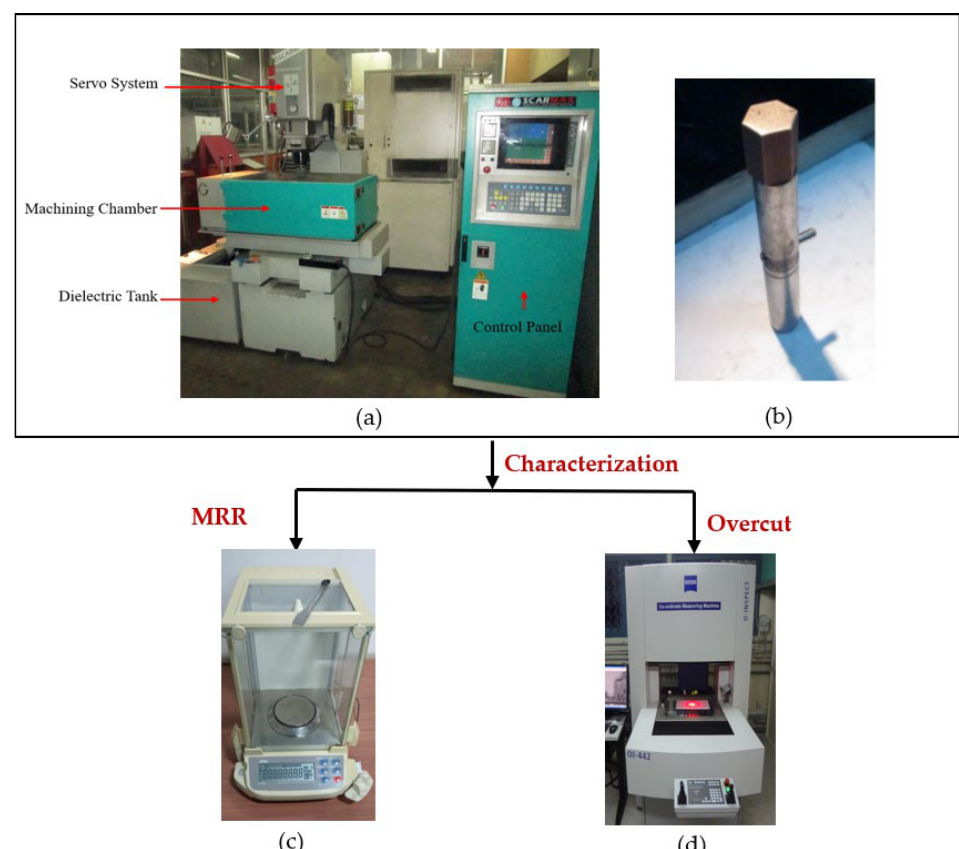
Figure 1. Electric discharge machining set-up. ( a ) Oscar electrical discharge machining machine. ( b ) Copper tool. ( c ) Weighing equipment. ( d ) Coordinate measuring machine (CMM). Table 1. Chemical constitution of pearlitic ductile iron.